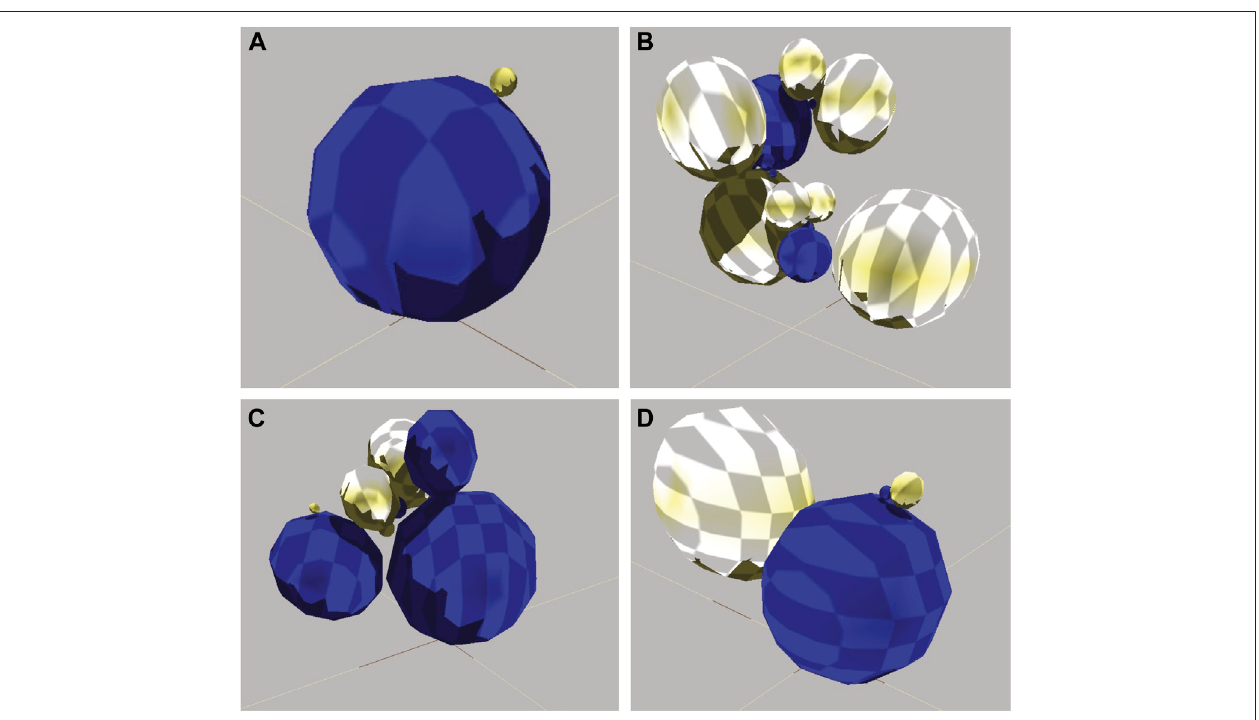
FIGURE 4 | Diversity of evolved robots. (A) Simple morphology with low fi tness. This is an 8th-generation agent with two spheres, one joint, four neurons, one sensor,andsixwires.Lackingamotor,therobotdidnotlocomote.Itsnon-zero fi tnessof0.10 misanartifactofitslargediameter. (B) Complicatedmorphologywithlow fi tness. This is a 92nd-generation robot with 16 spheres, 15 joints, four neurons, fi ve sensors, and three wires. The robot locomoted, but had too many moving parts to dosoinanef fi cientlinearfashion.Fitnessof24.49 m. (C) Intermediatemorphologyand fi tness.Thisisa56th-generationrobotwithsevenspheres,sixjoints,seven neurons,10sensors,andsixwires.Therobotexecutedasinglejump.Fitnessof199.80 m. (D) Simplemorphologyandhigh fi tness.Thisisa83rd-generationrobotwith four body spheres, three joints, seven neurons, fi ve sensors, and eight wires. It locomoted by continually fl ipping itself over (see Figure 5 ). Fitness of 1,068.83 m. Note that of all the parts, only spheres are shown here since their con fi guration dominates the external